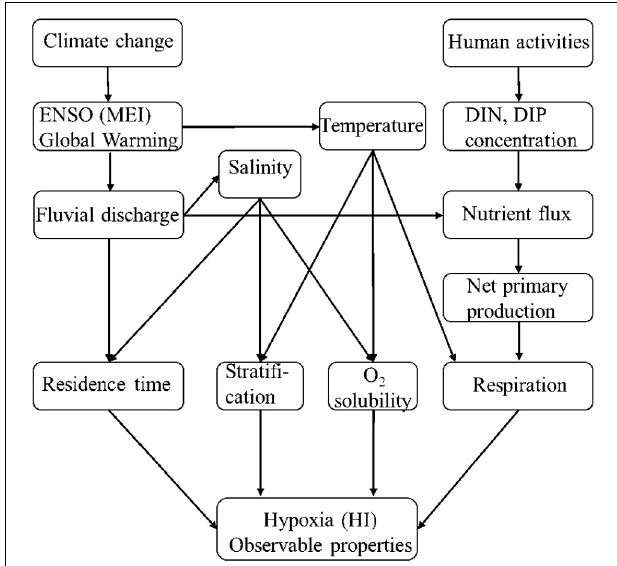
FIGURE 5 | Schematic diagram of factors controlling estuarine hypoxia. Climate change and anthropogenic activities affect coastal hypoxia by direct drivers through many